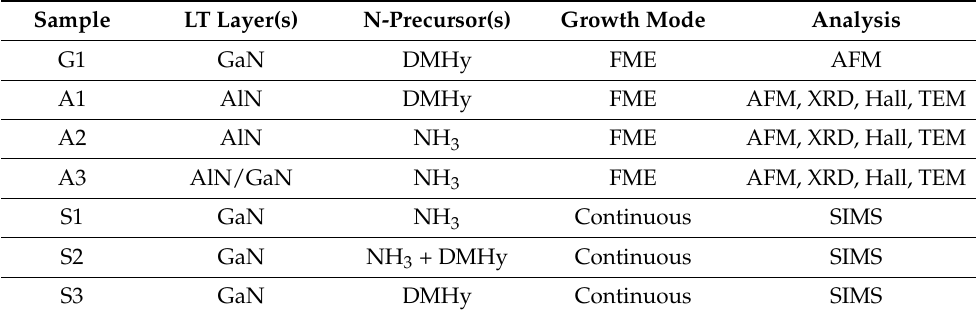
Table 1. List of LT FME samples and continuously grown LT SIMS layers